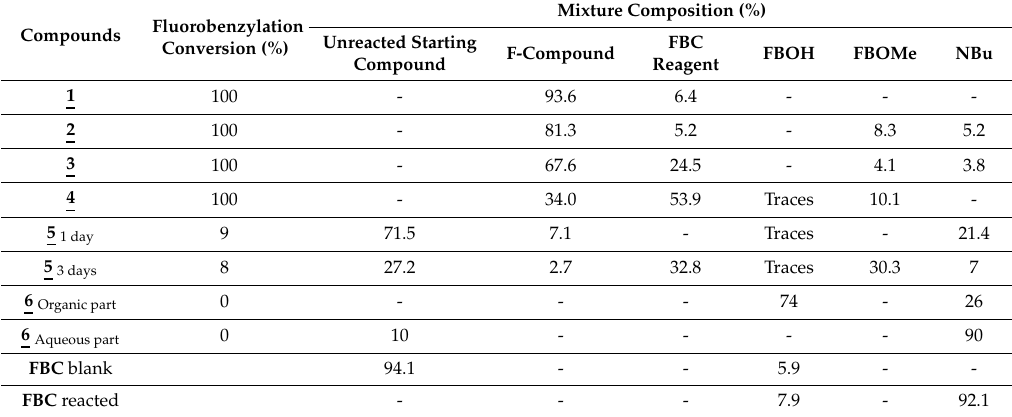
Table 2. Mixture ratio (in %) of model compound fluorobenzylation, calculated from 13 C-NMR data (Organic